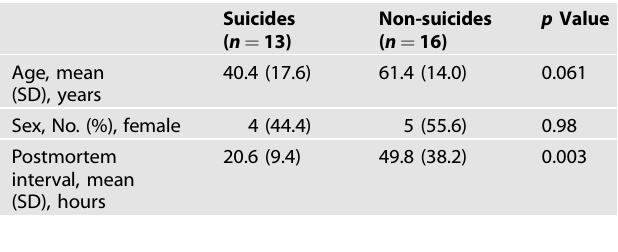
Table 1. Demographic characteristics of the suicides and non- suicides.